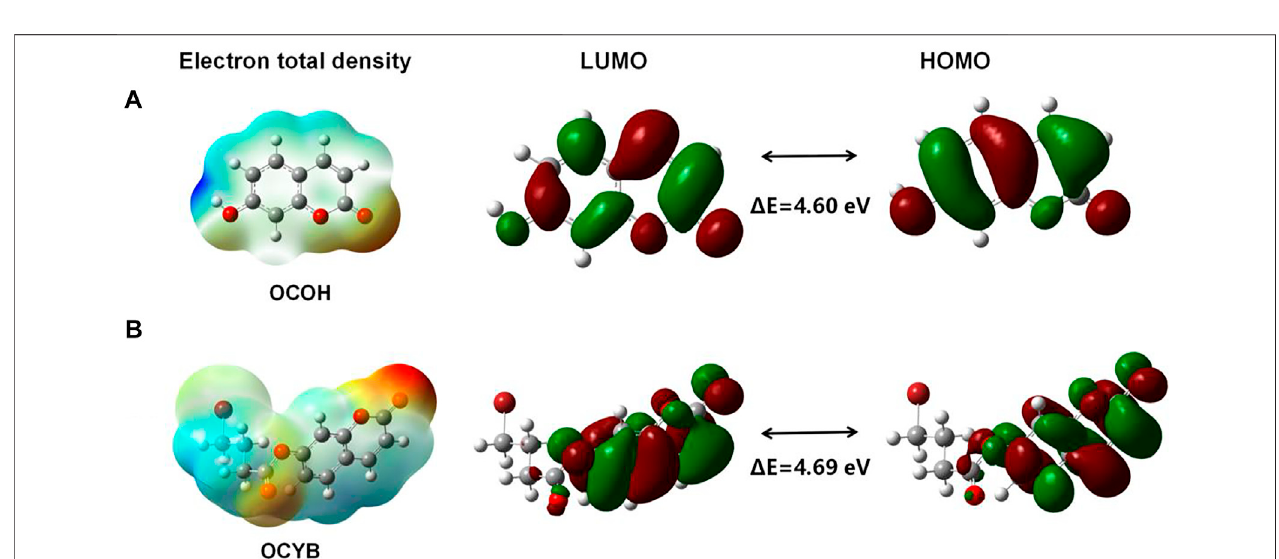
FIGURE 5 | Quantum chemical calculations of OCOH (A) and OCYB (B)